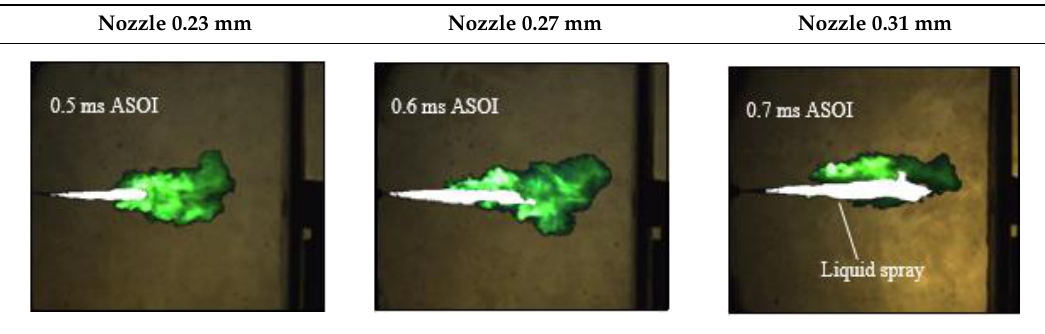
Table 6. Image of ignition time ASOI.